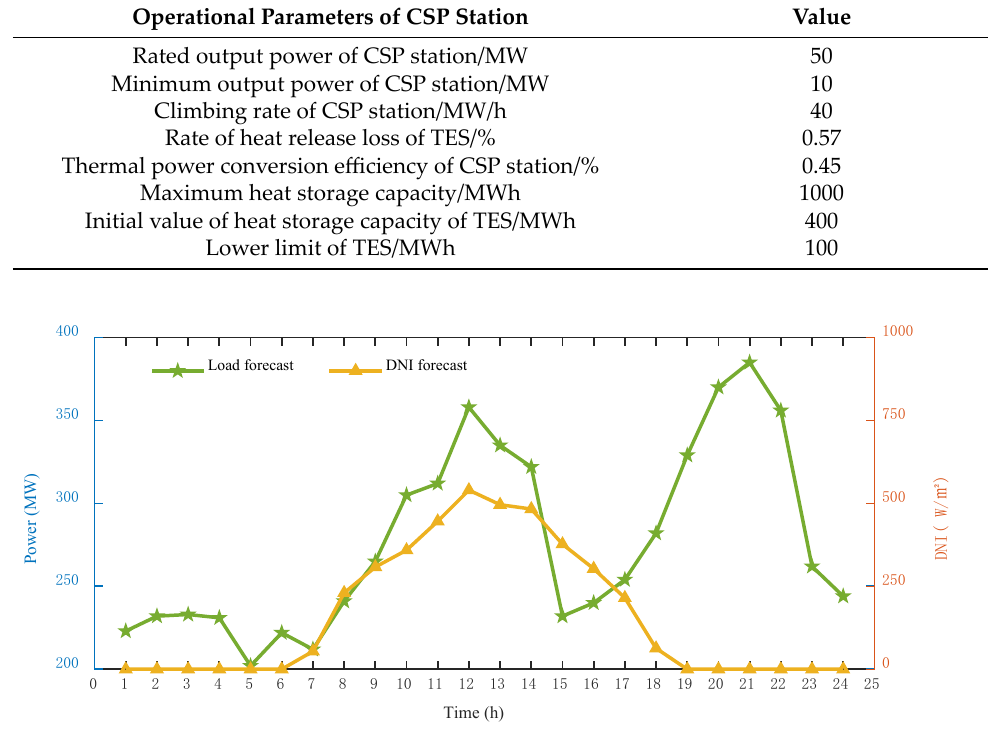
Table 2. Operating parameters of optimal thermal power station.